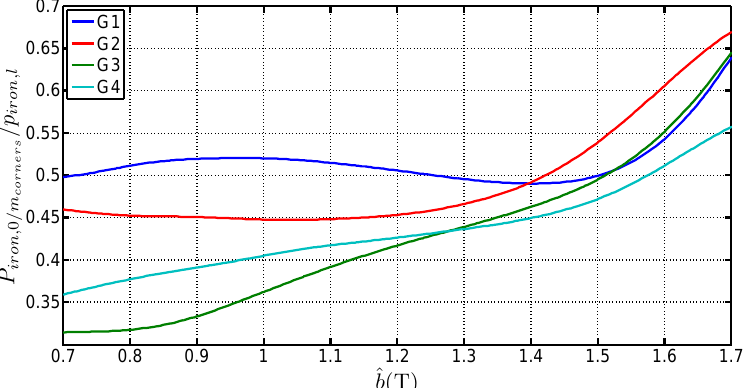
Figure 9. Variations of P iron ,0 with ˆ b for four steel grades and obtained with the three-frames method.